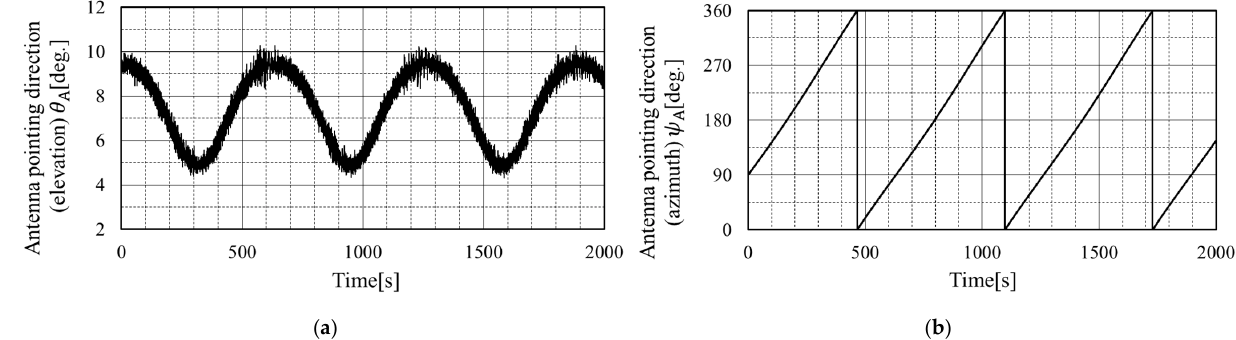
Figure 22. Time history of the antenna’s pointing directions. ( a ) Elevation. ( b ) Azimuth.